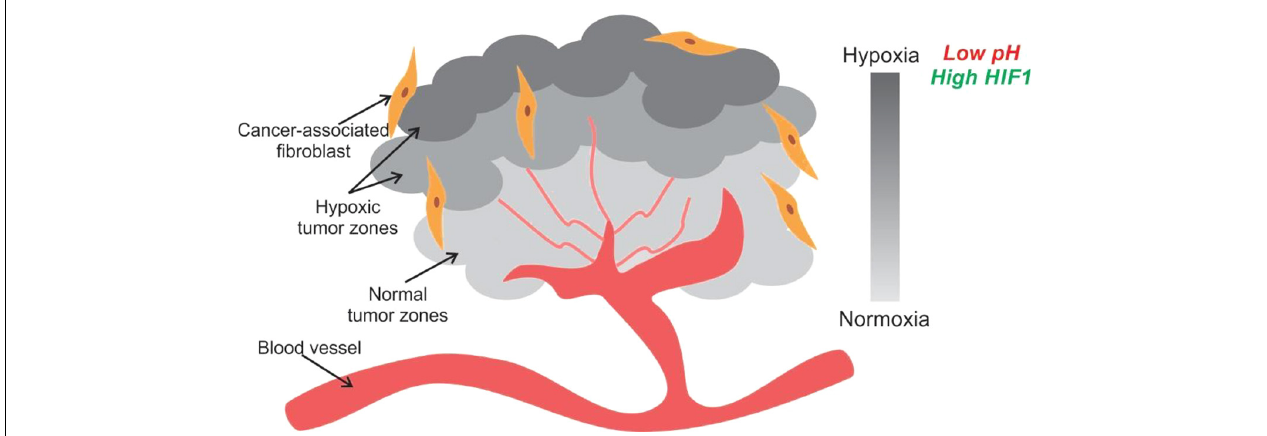
FIGURE 8 | Tumor hypoxia is observed due to spatial arrangement of cells. The tumor cells away from a blood vessel are in a hypoxic and acidic environment. They generate energy for proliferation by aerobic glycolysis. Some cells in the hypoxic zone secrete HIF1 and VEGF to initiate angiogenesis for securing nutrient supply.